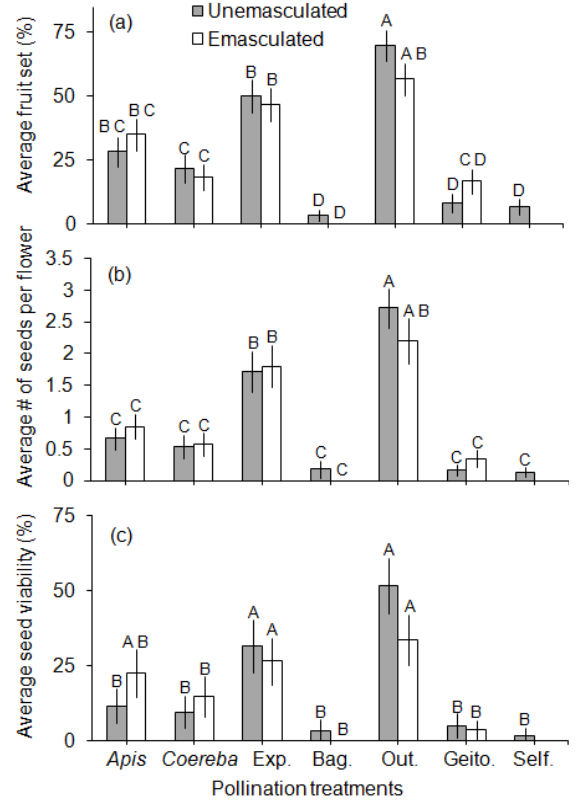
F IG . 2. Pollination treatments among unemasculated and emasculated flowers of Goetzea elegans . Columns show standard error bars, and different letters indicate statistical differences among treatments ( α = 0.05). Pollination treatments include visits of Apis mellifera ( Apis ), visits of Coereba flaveola ( Coereba ), exposed flowers (Exp.), bagged flowers (Bag.), outcrossed pollination (Out.), geitonogamous pollination (Geito.), and selfed pollination (Self.). (a) Average percentage of fruit set (%). (b) Average number of seeds per flower. (c) Average percentage of seed viability